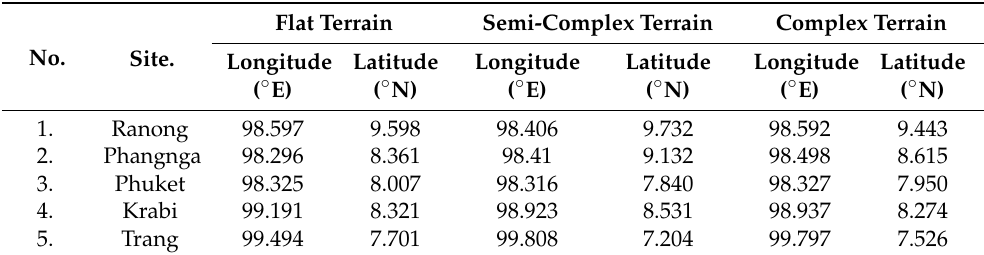
Figure 4. The climatic data points from the WRF model for the validation at various terrain characteristics. Table 1. Details of the representative points at an elevation of 120 m agl used in the validation of the mesoscale and microscale wind resource maps.